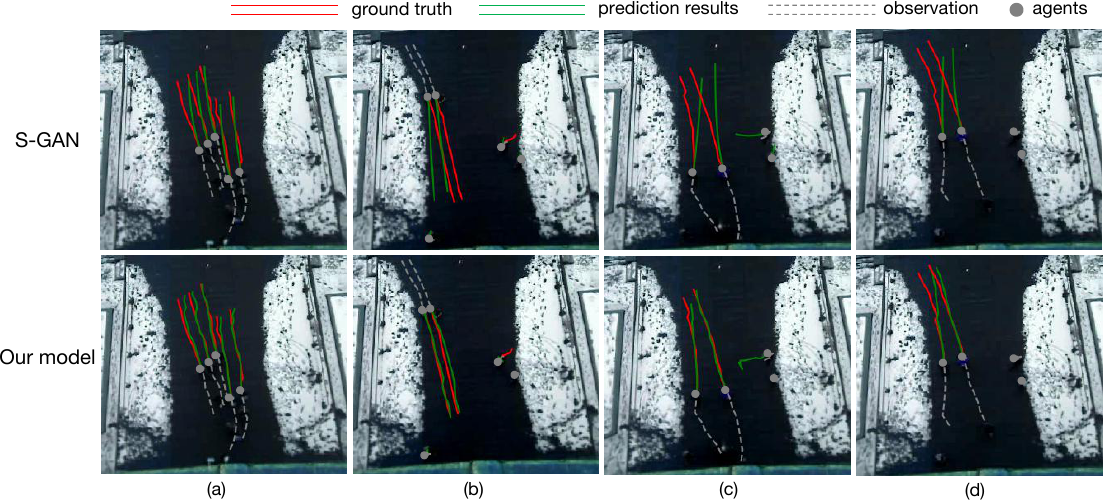
Figure 4. Comparison of predicted results from Social GAN (best result of 20 samples) and our model (best result of 20 samples). achieves slightly better results than the model S − T − L wta V 1 over univ, zara01 and zara02. But the second version S − T